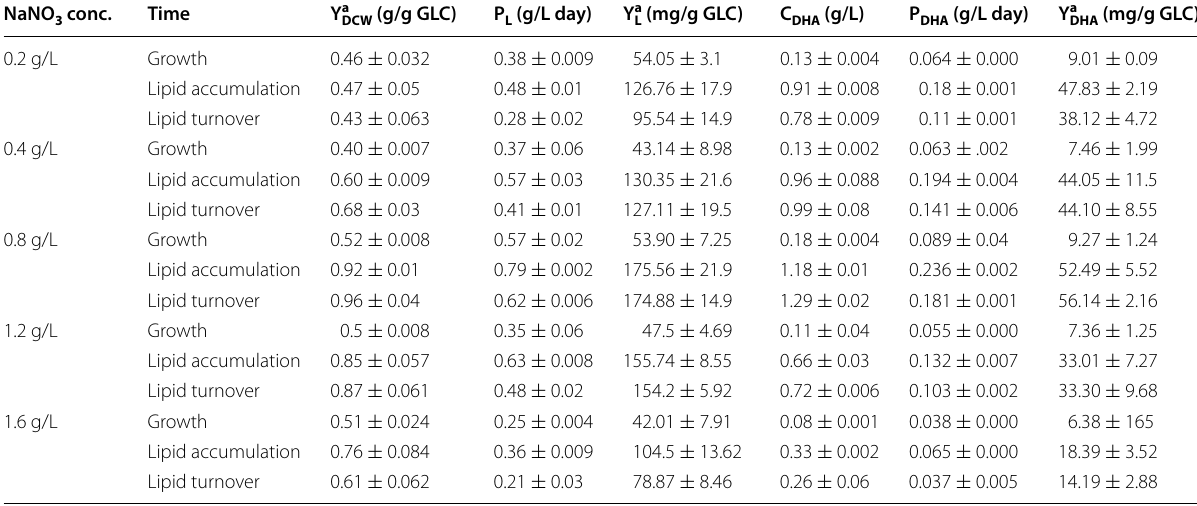
Table 2 Comparison of biomass yield, DHA content, DHA productivity, lipid and DHA yield of C. cohnii under different concentrations of NaNO